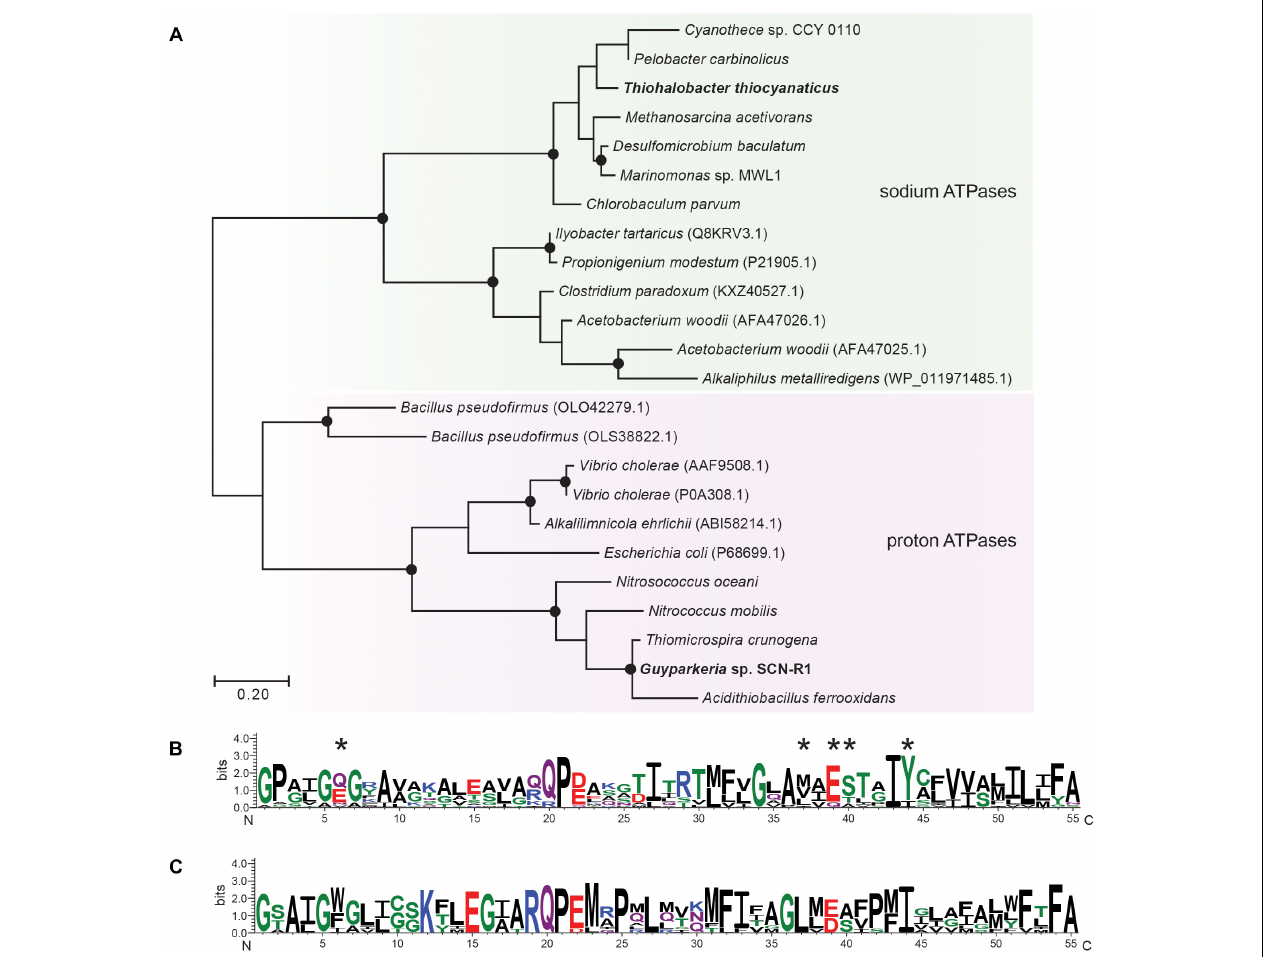
FIGURE 3 | Maximum likelihood tree (A) and sequence logos of sodium (B) and proton-dependent (C) ATP synthases (C-subunit). The sequences of Gyparkeria sp. SCN-R1 and Thiohalobacter thiocyanaticus HRh1 T are written in bold type. The sodium ligands are indicated with asterisks including the Na + -binding motif ESTxxY (see Mulkidjanian et al., 2008). The black dots on the tree indicate bootstrap values between 100 and 75% out of 100